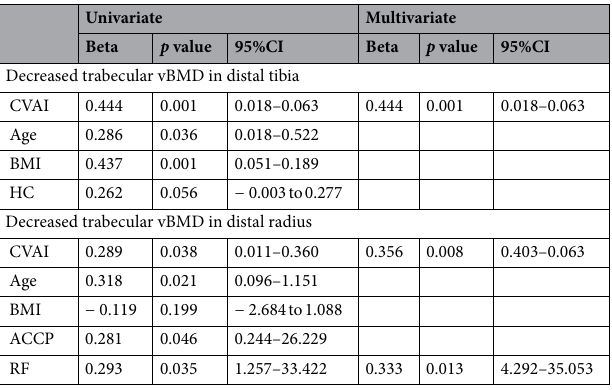
Table 4. Association between CVAI and changed bone microstructure in female ERA. vBMD: volumetric bone mineral density; CI: confidence interval; CAVI: Chinese adiposity visceral index; HC: hip circumference; BMI: body mass index; ERA: early rheumatoid arthritis; RF: rheumatoid factor; ACCP: Autoantibodies binding to citrullinated